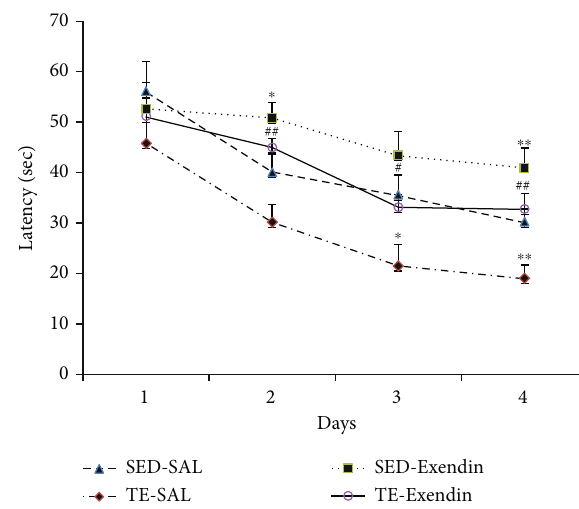
Figure 1: E ff ects of using the GLP-1 receptors antagonist (exendine-3) during treadmill exercise on learning tested by the MWM task. Data are expressed as the mean ± SEM . ∗ is for P < 0 : 05 and # is for P < 0 : 01